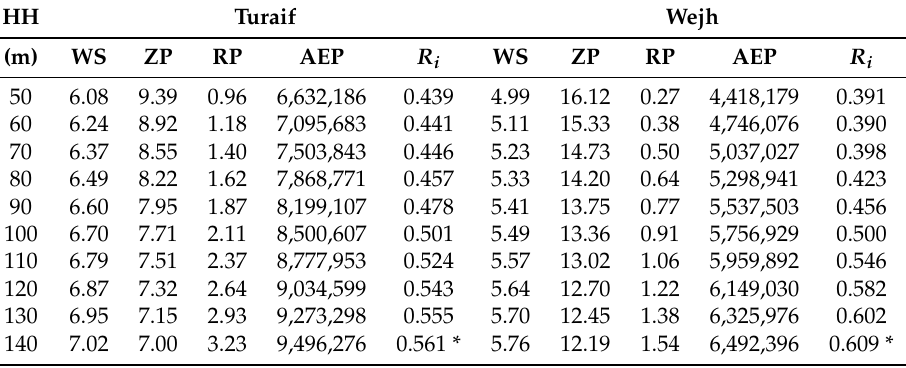
Table A12. TOPSIS analysis for turbine Sinovel SL3000/115. The best choice for each site is marked with an